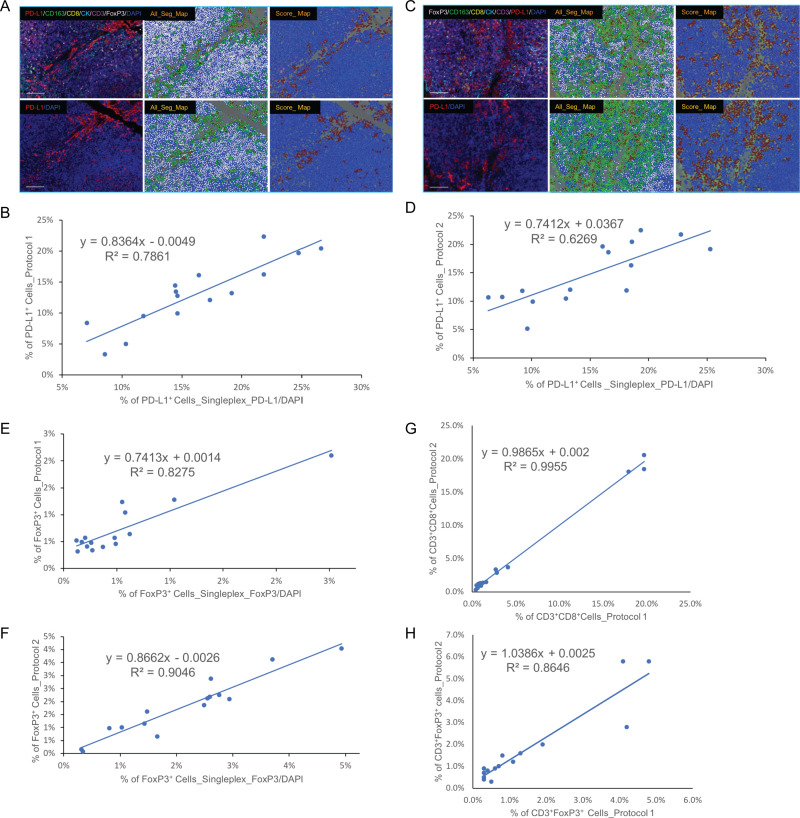
Quantification analysis on PD-L1+, FoxP3 +, CD3+CD8+, and CD3+FoxP3+ cell populations.Quantification analysis confirmed the percent PD-L1+ cell population determined by mIHC is comparable with singleplex IHC in the adjacent sections (A-D). The threshold of PD-L1+ cell populations was determined by a Board-certificated Pathologist. The staining intensity of PD-L1 cells above the threshold were recognized as positive cells. The mIHC stain followed Protocol 1 in (A) and Protocol 2 in (C). Similar analysis was conducted with respect to FoxP3 expression (E, F). CD3+CD8+ and CD3+FoxP3+ cell populations stained by Protocol 1 and Protocol 2 were analyzed (G, H).